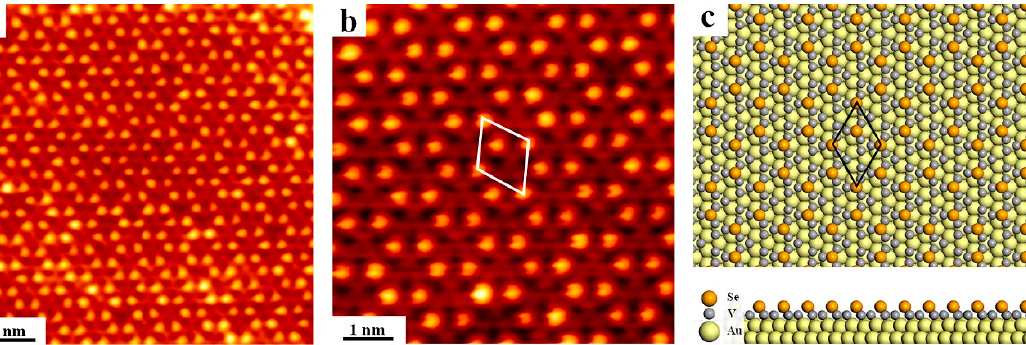
Figure 4. The hexagon-like pattern formed on Au(111) with a varied ratio of V to Se. ( a ) The overview and ( b ) zoom-in view of the hexagonal defect structures with the white rhombus highlighting the unit cell. ( c ) Top and side views of the relaxed model of the hexagonal structures. Scanning parameters: ( a ) U bias = − 1.5 V, I t = 0.92 nA; ( b ) U bias = − 1.5 V, I t = 1.05 nA.